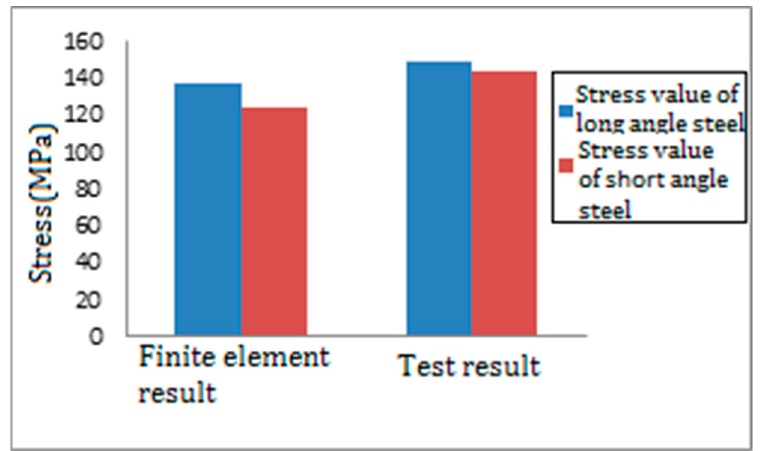
Figure 20. Comparison of stress test value and finite element value on long and short angle steel.